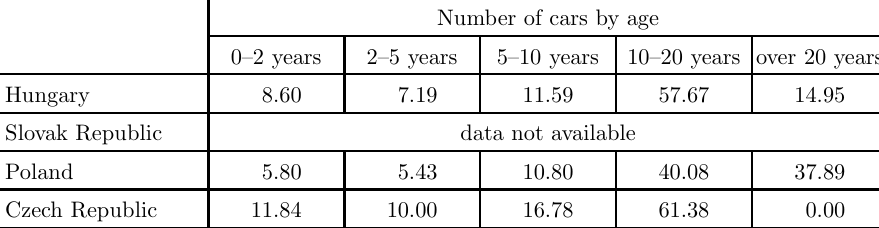
Passenger car fleet in the V4 countries by age of cars, % share, 2019 Number of cars by